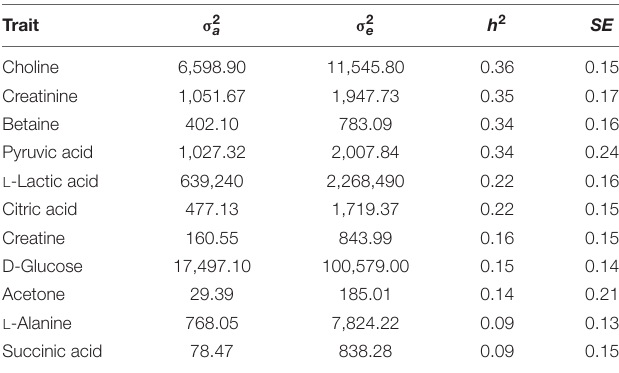
TABLE 2 | Estimates of additive variance ( σ 2 a ), residual variance ( σ 2 e ), heritability ( h 2 ) and their standard error ( SE ) for 11 plasma metabolites a .